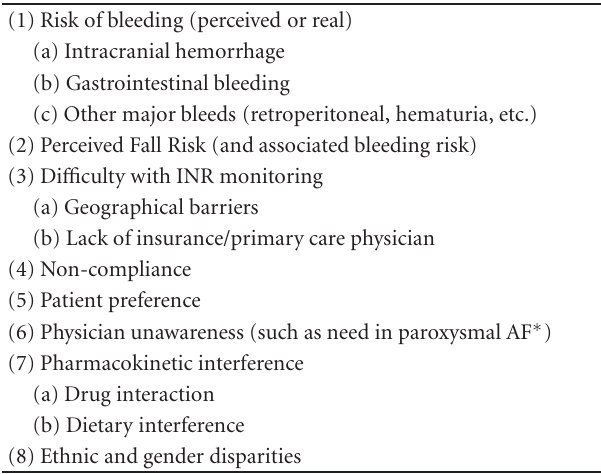
Table 1: Causes of warfarin